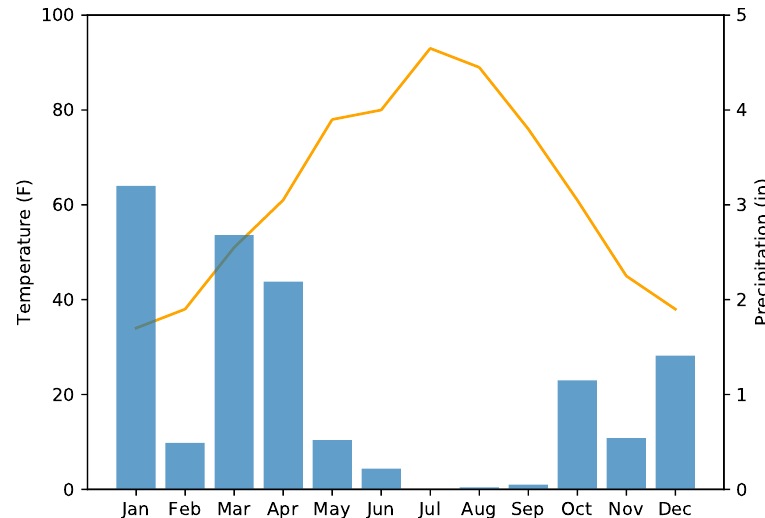
Figure 3. Study area: ( a ) Washington State scale map showing the location as a star mark and the acquisition geometries of Sentinel-1 as blue rectangles; ( b ) local scale map showing the location as a red rectangle; and ( c ) high-resolution image of the entire study area.